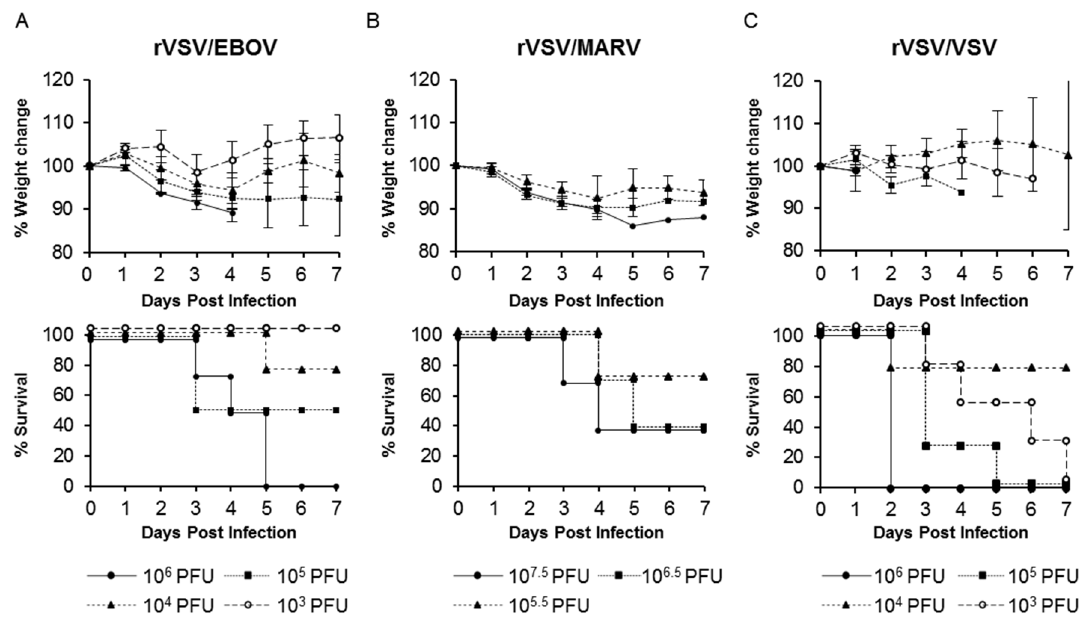
Figure 2. Body weight changes and survival curves of Syrian hamsters infected with rVSV / EBOV, rVSV / MARV, or rVSV / VSV. ( A ) Four hamsters were infected i.p. with 10 6 , 10 5 , 10 4 , or 10 3 PFU of rVSV / EBOV. ( B ) Three hamsters were infected i.p. with 10 7.5 , 10 6.5 , or 10 5.5 PFU of rVSV / MARV. ( C ) Four hamsters were infected i.p. with 10 6 , 10 5 , 10 4 , or 10 3 PFU of rVSV / VSV. All animals were monitored for body weight and survival for 7 days post-infection (dpi). The symbols represent mean group weights and the bars represent standard errors ( A , B , and C upper panel).